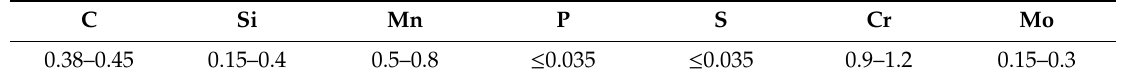
Table 4. The chemical composition of steel EN 42CrMo4 (%).